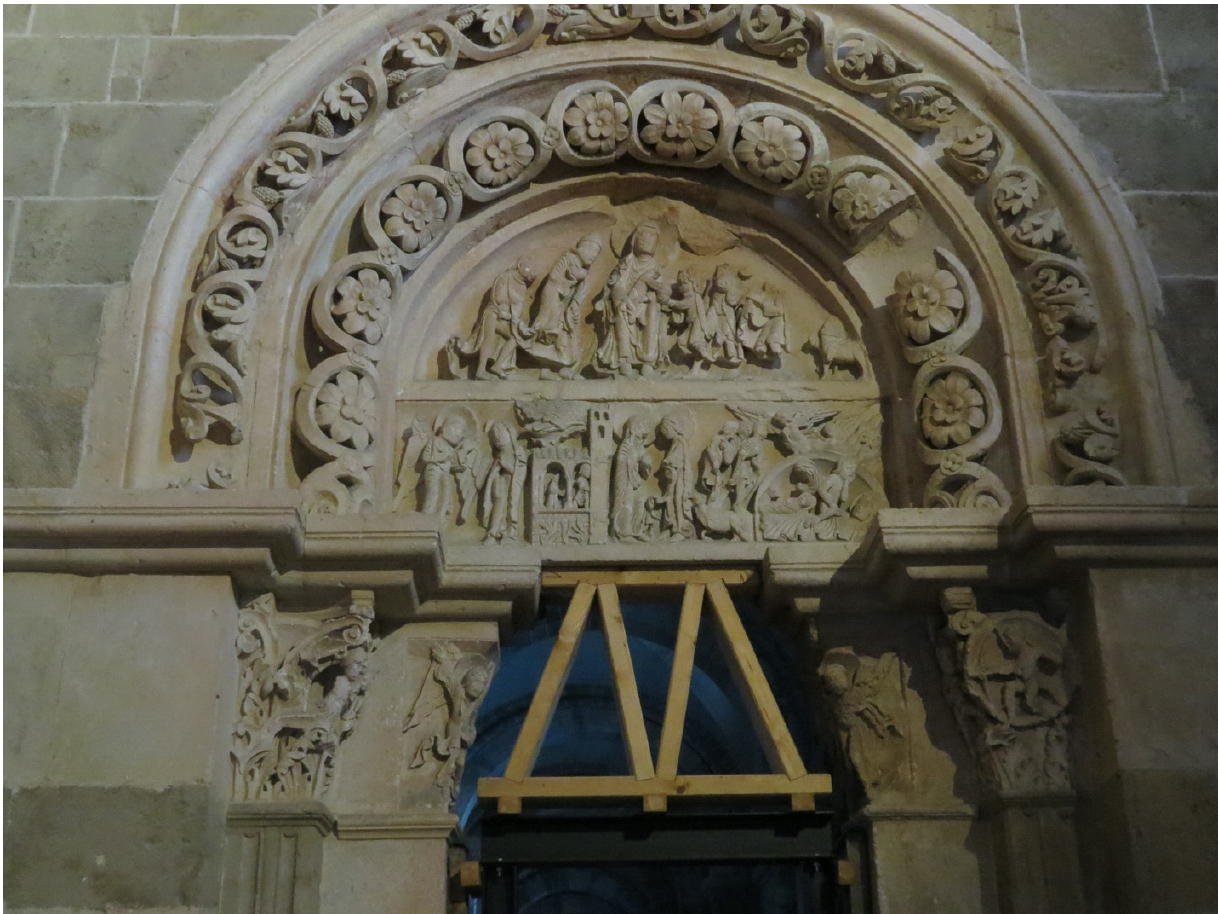
Figure 26. Incarnation and Nativity of Christ, detail of tympanum, right narthex portal, ca. 1140– 1150., Abbey Church of Sainte-Marie-Madeleine , Vézelay, Yonne, Bourgogne, France.